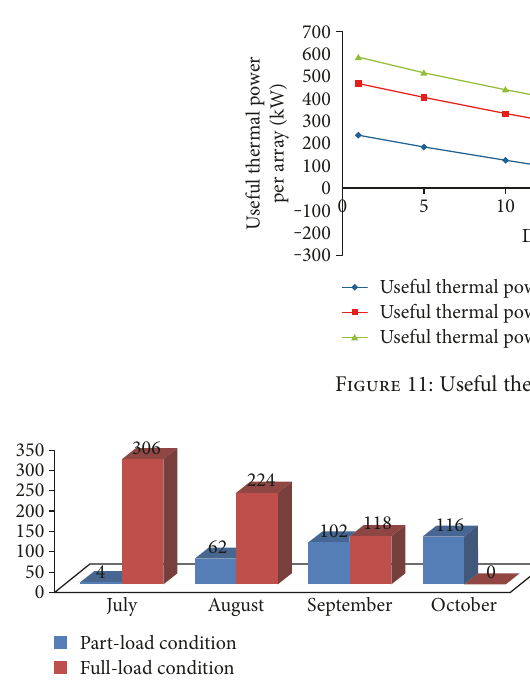
Figure 12: Operating hours of the solar fi eld in July, August,